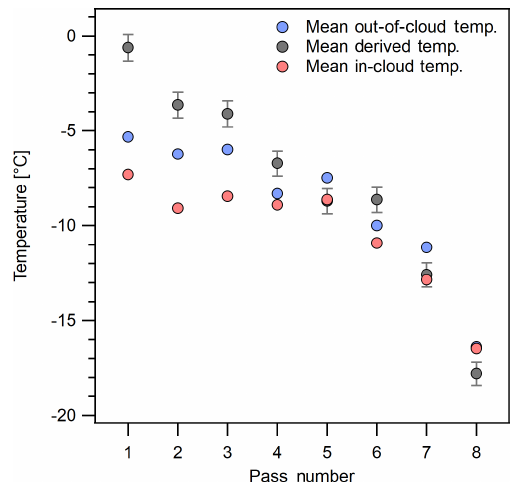
Figure 2. Temperatures as a function of penetration number from the Rosemount de-iced sensor out of cloud prior to penetration of cloud (blue markers), the wetted Rosemount de-iced sensor in cloud (red markers) and the derived temperature (grey markers). Error bars for the derived temperature represent propagation of ± 5% er- ror in the WVSSII water vapour mixing ratio measurement.